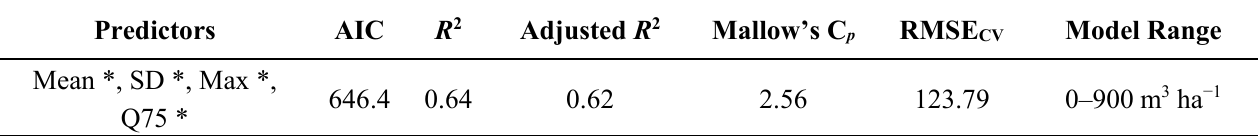
Table 4. Summary statistics of the regression